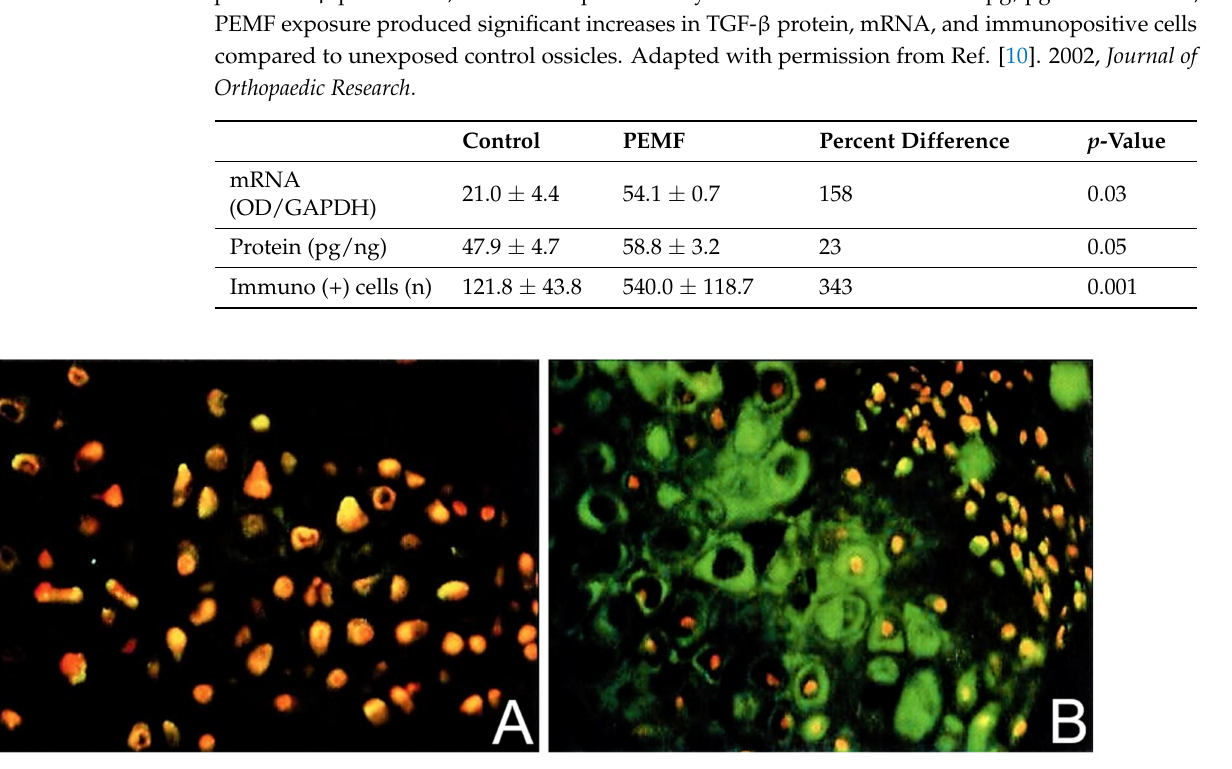
Figure 10. Immunohistochemistry of TGF- β 1 synthesis with PEMF exposure. ( A ) Unexposed ossicles showing propidium iodide staining nuclei (red) and no TGF- β 1 staining in the ECM (40 × ). ( B ) PEMF- stimulated ossicles showing TGF- β 1 synthesized by chondrocytes in areas of cartilage formation (green) rather than by mesenchymal stem/stromal cells (40 × ). Adapted with permission from Ref. [10]. 2002, Journal of Orthopaedic Research .